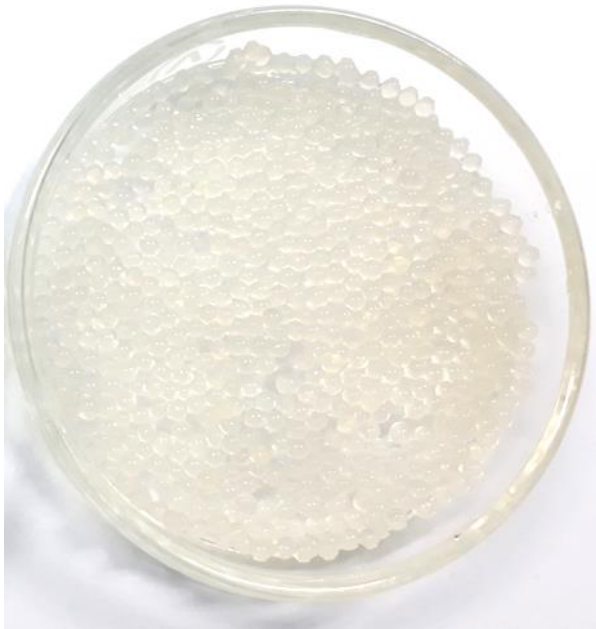
Figure A1. Image of the microcapsules obtained in optimum conditions (sodium alginate concentration of 3.1%( w / v ), chitosan concentration of 0.2%( w / v ), calcium chloride concentration of 0.14 M, and complexation time of 1 min).